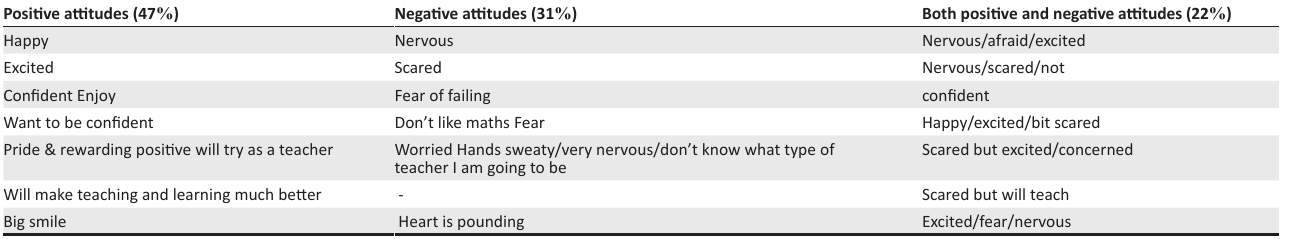
TABLE 4: Participants’ attitudes in relation to their roles as future mathematics teachers in the Foundation Phase. Positive attitudes (47 %